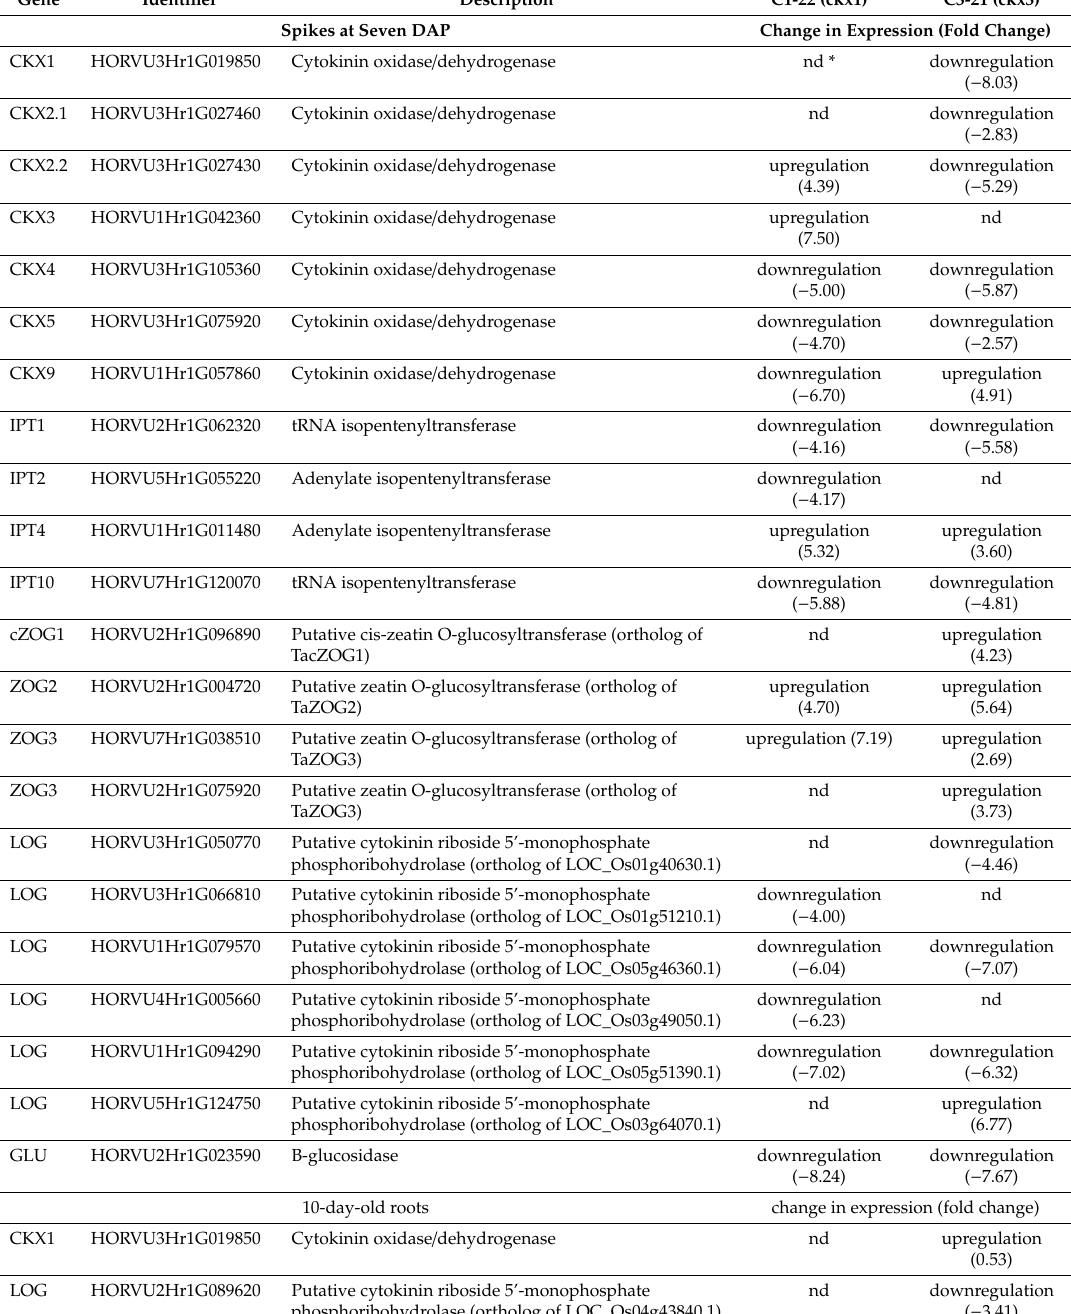
Table 2. List of di ff erentially expressed genes involved in cytokinin metabolism identified in the ckx1 and ckx3 mutant